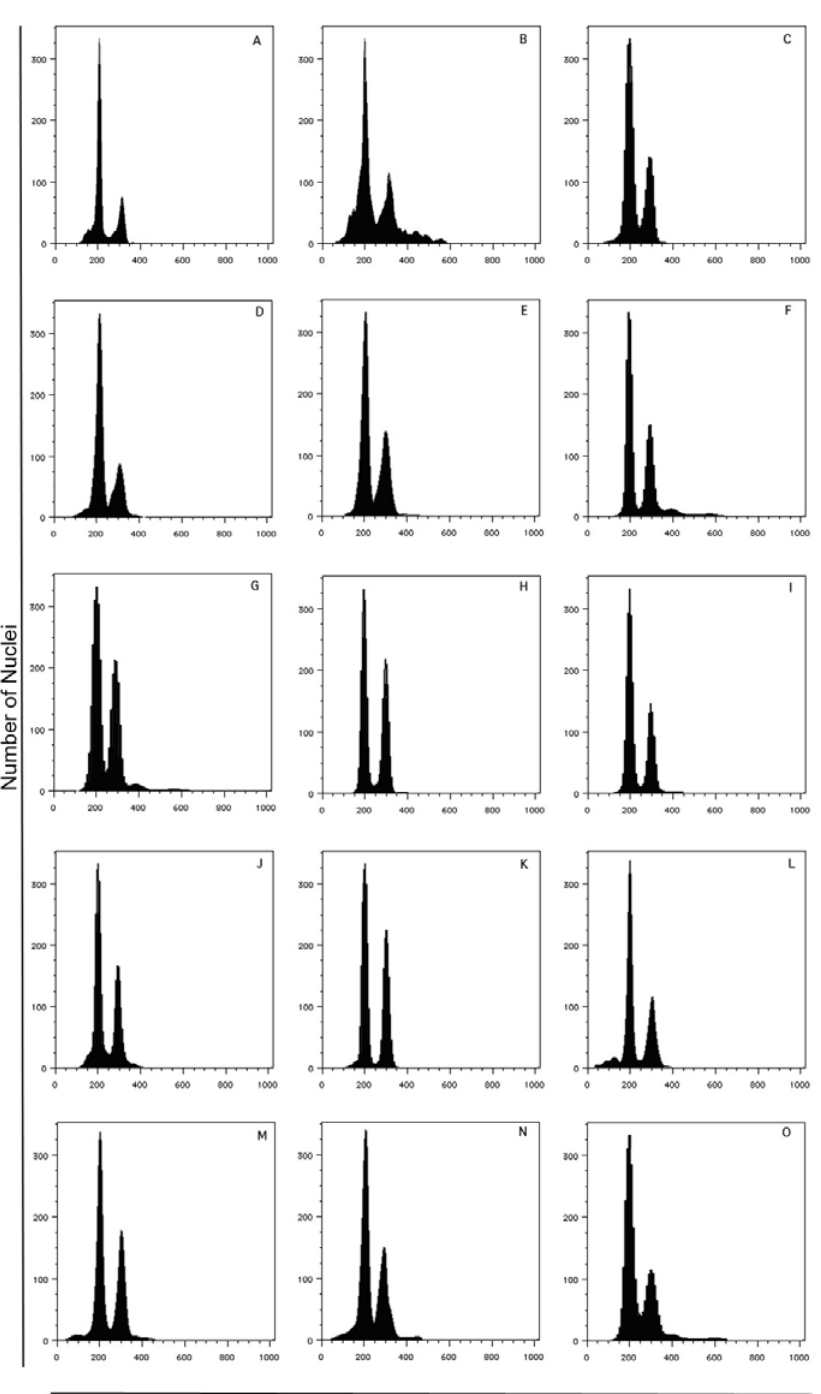
Figure 7. Ploidy evaluation by flow cytometry analysis of DAPI stained nuclei in suspension isolated from single seeds of 15 J. curcas accessions: A, JcTUT; B, JcCOI;